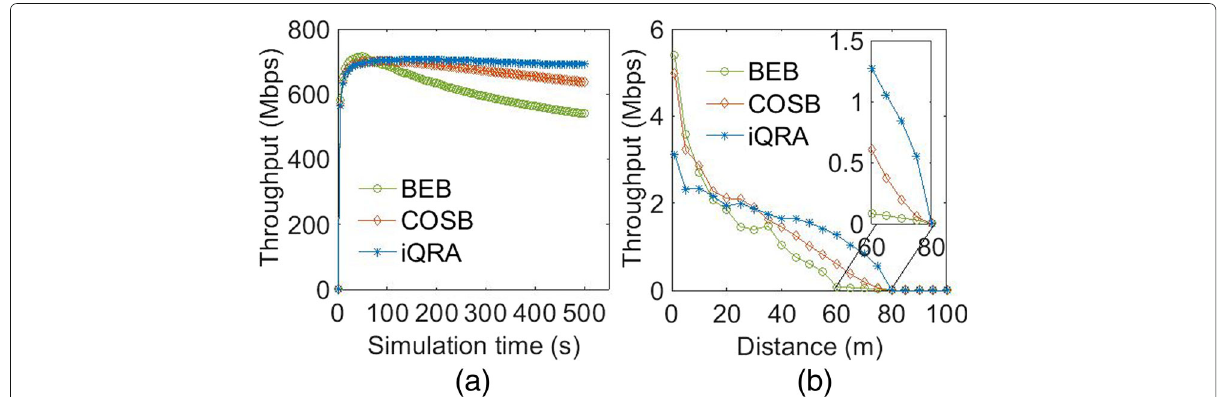
Fig. 9 Throughput comparison of BEB, COSB, and i QRA in a dynamic network environment with increasing number of contenders after every 50s and b distance-based rate adaptation network